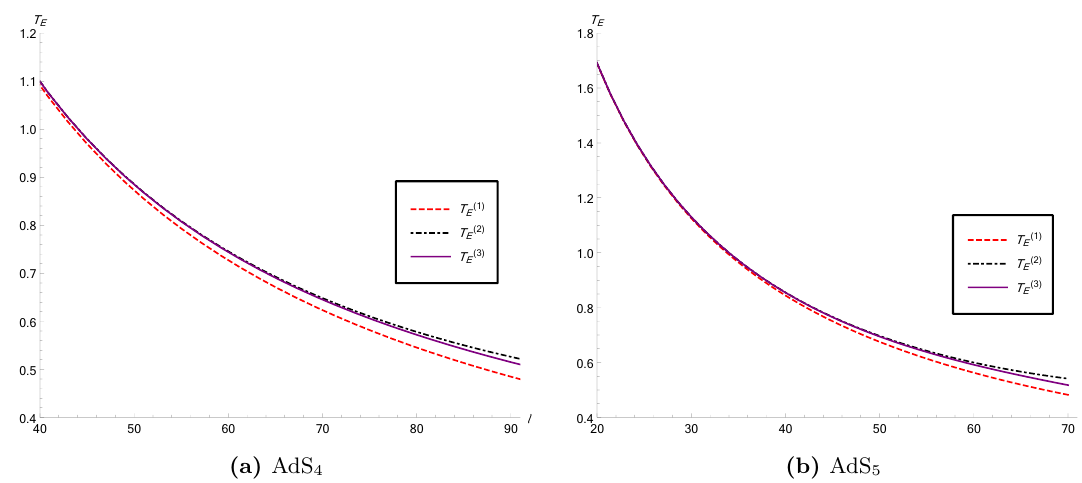
Figure 2. The entanglement temperature with and without higher order corrections for d = 3 and 4 , plot drawn for z h = 100 and β = 0 . 25